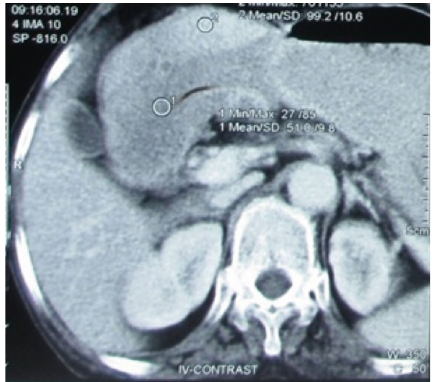
Figure 1: Axial computed tomography image of the abdomen showing a thickened wall of the stomach at the body and pyloric